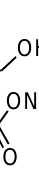
Figure 3. The sodium salt of CPT 15 .